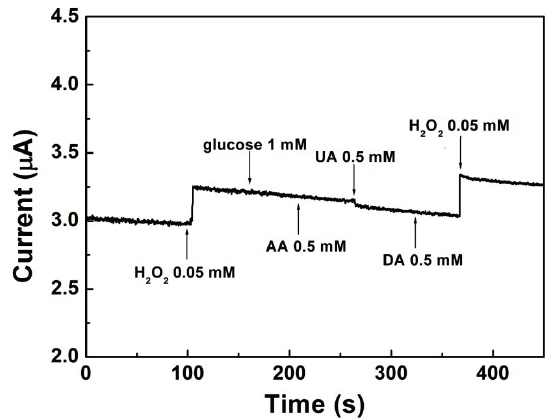
Figure 7. Current-time response curve at Pt-Au/rGSs/GCE for successive injection of H 2 O 2 , glucose, AA, UA and DA in 0.1 M PBS at 0 V.